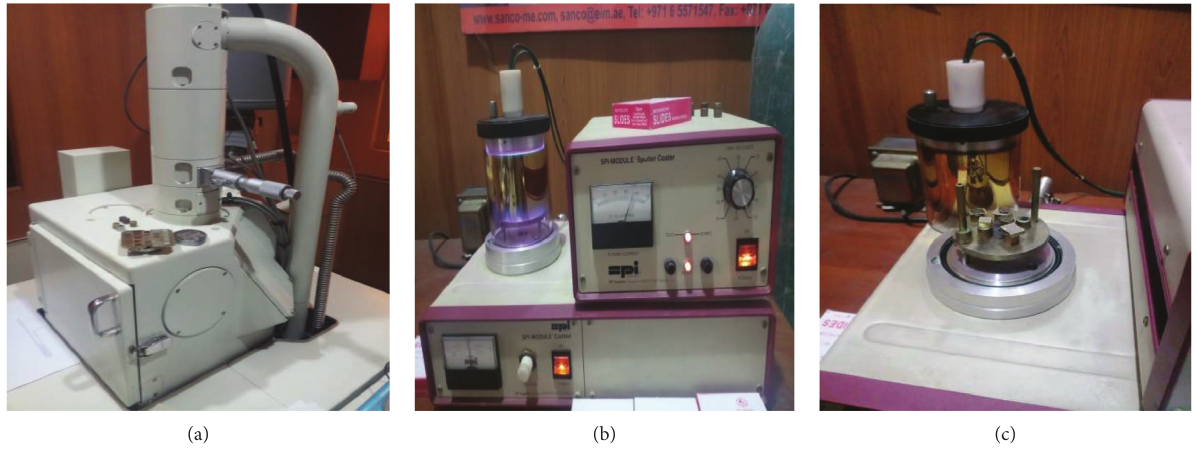
Figure 6: SEM set-up: (a) SEM-JEOL JSM IT100, (b) sputter coater, and (c) asphalt specimen coating.